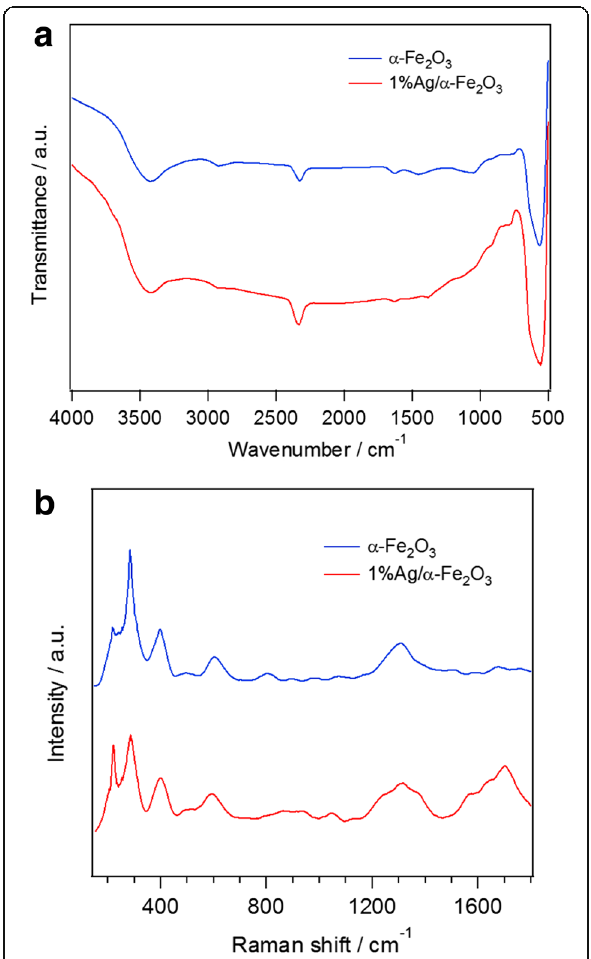
Fig. 2 a FTIR and b Raman spectra of α − Fe 2 O 3 and 1%Ag/ α − Fe 2 O